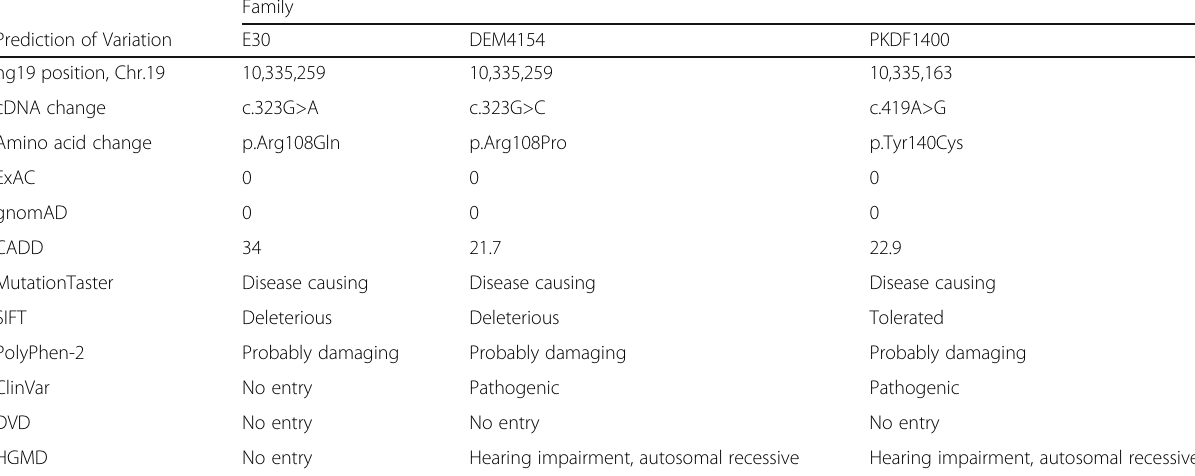
Table 2 Comparison of all known human S1PR2 pathogenic variants